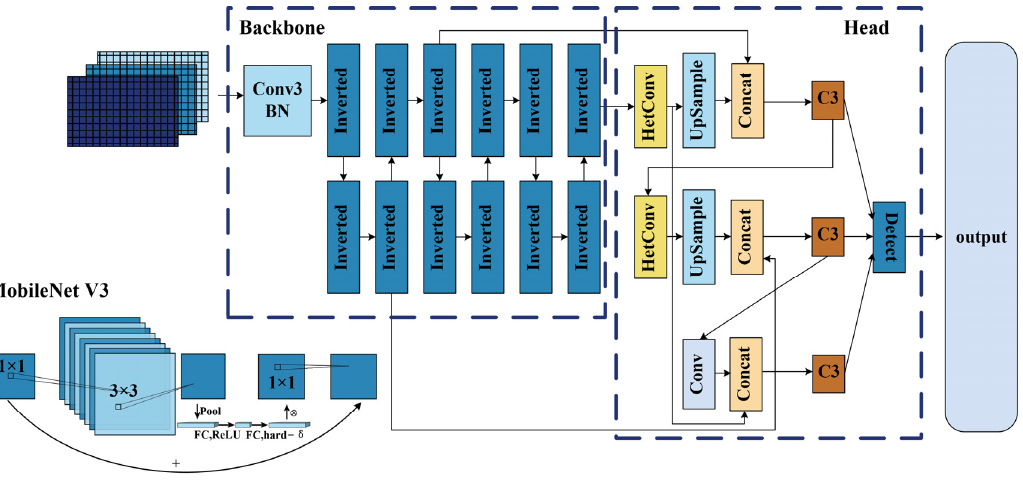
Figure 1. The overall network framework.